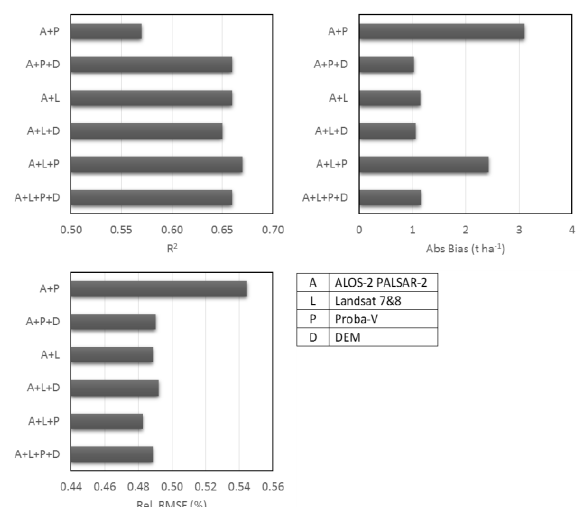
Figure 4. Jackknife analyses based on R 2 , bias and RMSE for the potential input variables Figure 6. Scatterplot AGB map vs. AGB reference The AGB stocks calculated using the AGB map were comparable to current estimates from the NFI. Table 1 shows that although the AGB estimates derived from the map are lower than the NFI estimates, the differences are not significative. The total AGB estimate for the whole country was only a 2.93% lower than the NFI national estimate, while regionally the differences were between 0.87% and 28.19% (Table